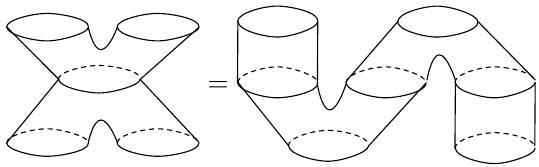
Figure 31 . One possible topology change.